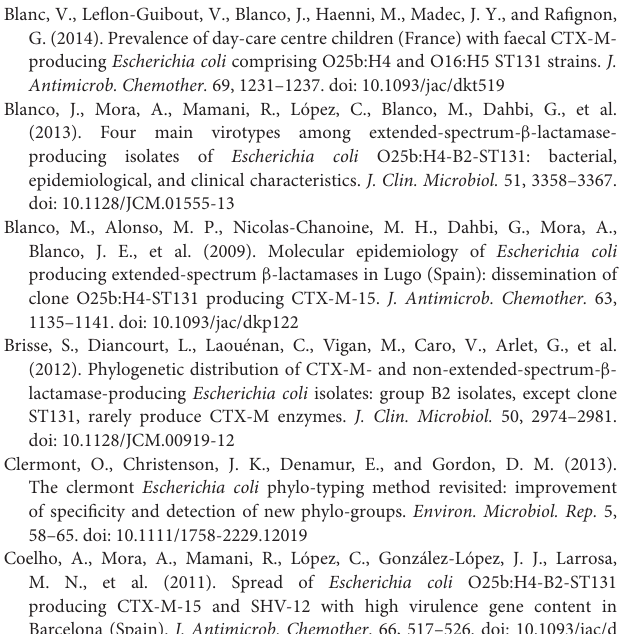
Table S1 | Characteristics of 188 extended-spectrum β -lactamase-producing Escherichia coli (ESBL-EC) collected in 2015 in Lucus Augusti University hospital (Lugo, Spain) and AP-HP Beaujon hospital (Clichy,